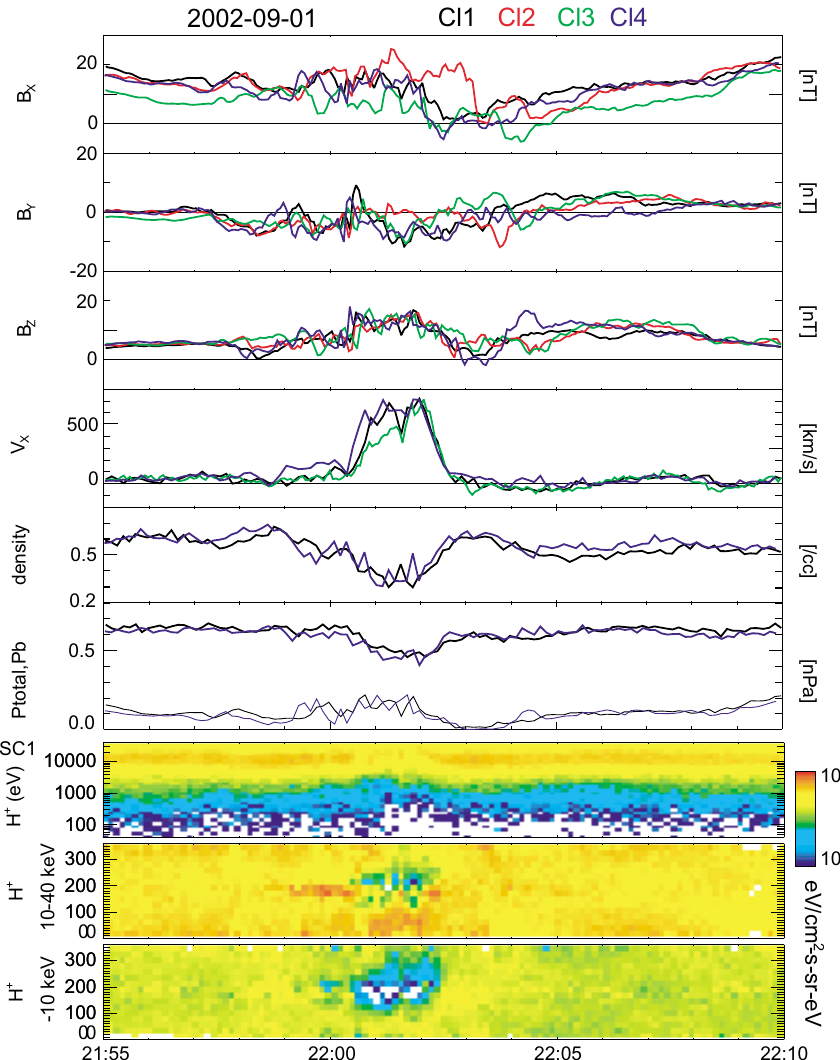
Fig. 3. X , Y and Z component of the magnetic field from the four Cluster spacecraft, X component of the ion flows from Clusters 1, 3, and 4, and proton density and pressures obtained by Clusters 1 and 4 between 21:55 and 22:10 UT. The thick lines in the pressure panel represent to the total pressure, whereas the thin lines the magnetic field pressure. The bottom three panels show the proton energy spectra, pitch angle distribution of high energy (10–40keV) and low energy (100eV–10keV) protons for Cluster 1.